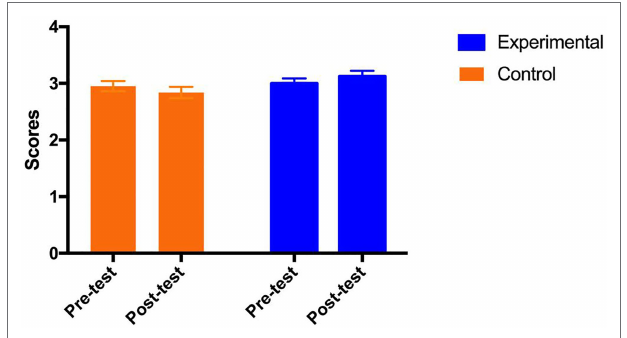
FIGURE 2 | Adjusted means (SEs) for positive affect by group and test.